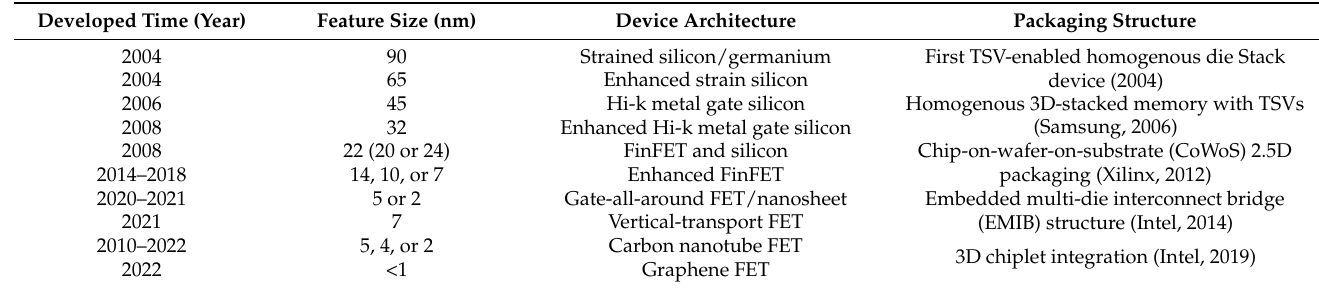
Table 1. Recent milestones in IC development: feature sizes and packaging